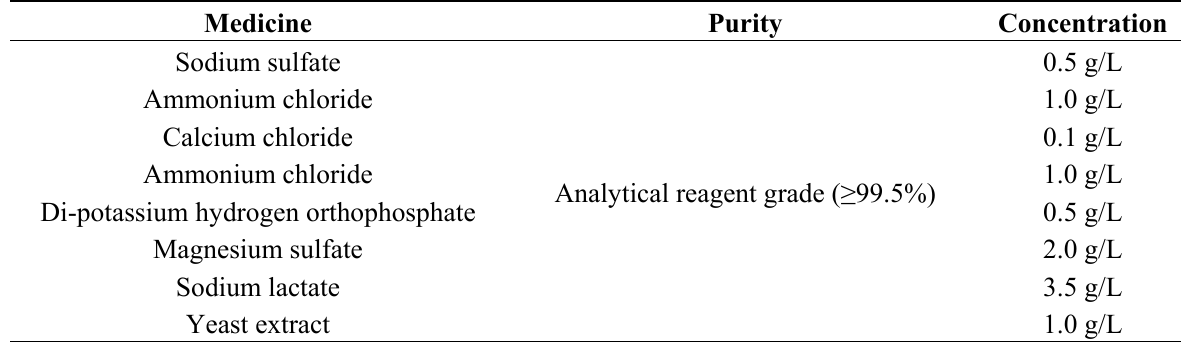
Table 2. Main composition of the culture media and their